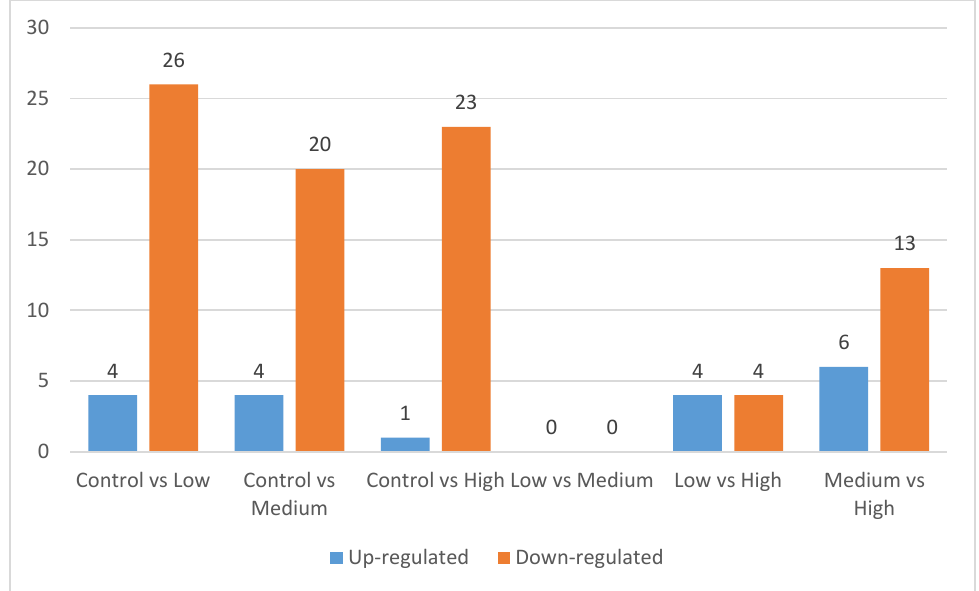
Figure 4. Number of differentially expressed proteins in six comparisons: Control vs. Low, Control vs. Medium, Control vs. High, Low vs. Medium, Low vs. High and Medium vs. High.